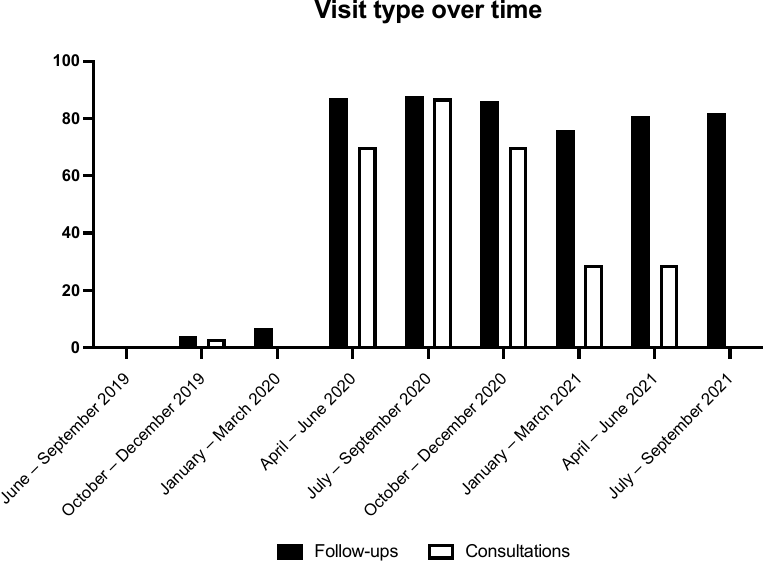
Figure 1. The relationship of visit type over time during the observation period. The Y-axis represents the proportion of virtual visits.